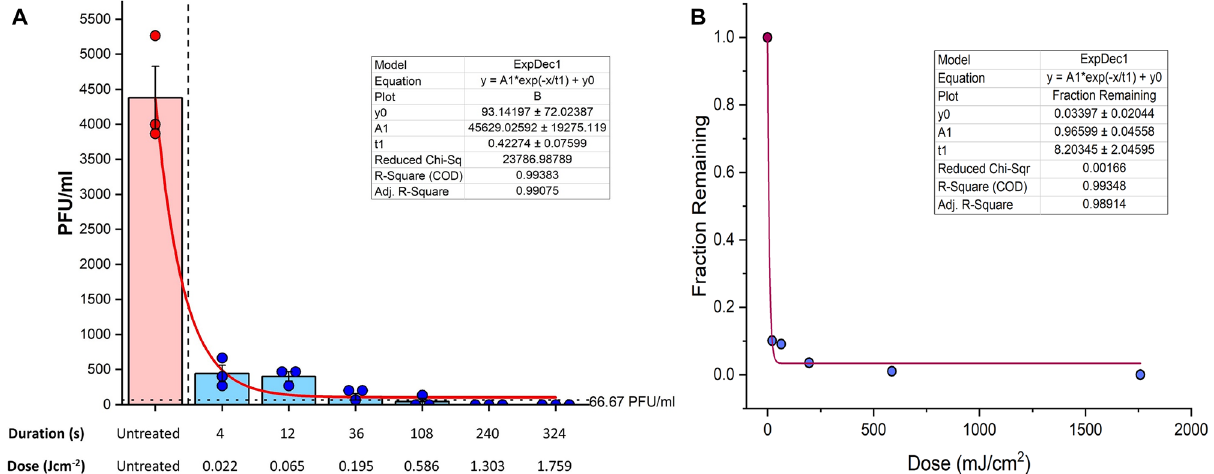
Figure 3. UVC irradiation for 240 s induces over 3.5 log reduction in SARS-CoV-2 viral titers. ( A ) Time course of log reduction of SARS-CoV-2 in N95 test coupons treated with UVC irradiation. N95 mask squares (2.5 cm 2 ) with all layers were incubated with infection media spiked with SARS-CoV-2 for 15 min. The respirator coupons were then placed on open 10 cm polystyrene cell culture dishes 15.2 cm from the lamp. After warming up the lamp, the blocks were treated for the indicated amount of time per each side. Respirators were left in infection media at 4 °C overnight. One ml of the mask derived media mix was used from each condition and was titered in VERO-E6 cells using plaque assays targeting the SARS-CoV-2 Spike (S) and Nucleocapsid protein (NP). Each dot represents data from three independent experiments and plotted data bars represent mean and standard deviation for the triplicates. Vertical dashed line delineates untreated and treated parts of the experiment. Horizontal dotted line is the minimal level of detection (approximately 67 PFU ml −1 ). Baseline for the assay is shown using a continuous line. ( B ) Regression analysis of viral reduction as per timely UVC irradiation.